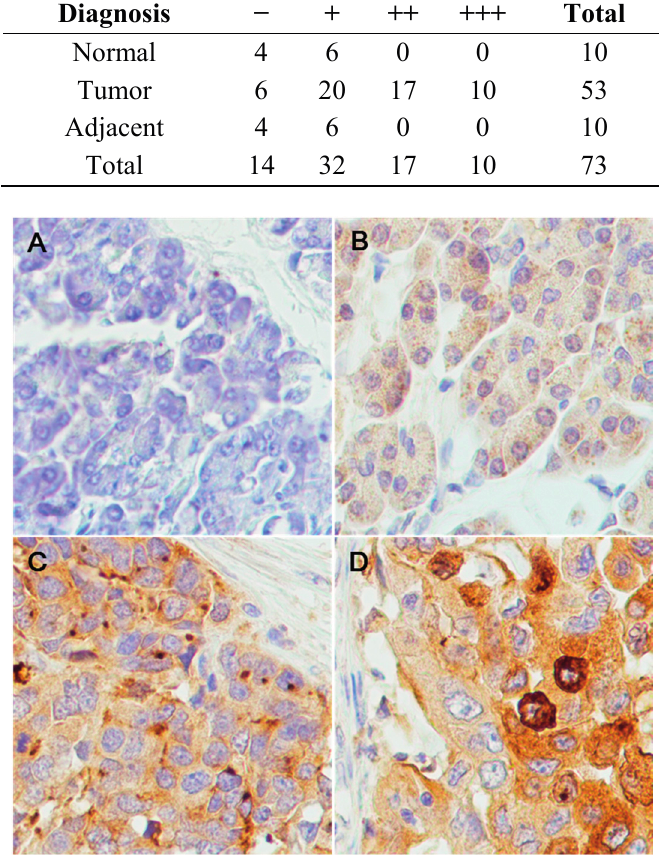
Figure 2. Representative results of HE4 immunohistochemisrty staining. Tissue cores were stained with antibodies against human HE4 and counterstained with